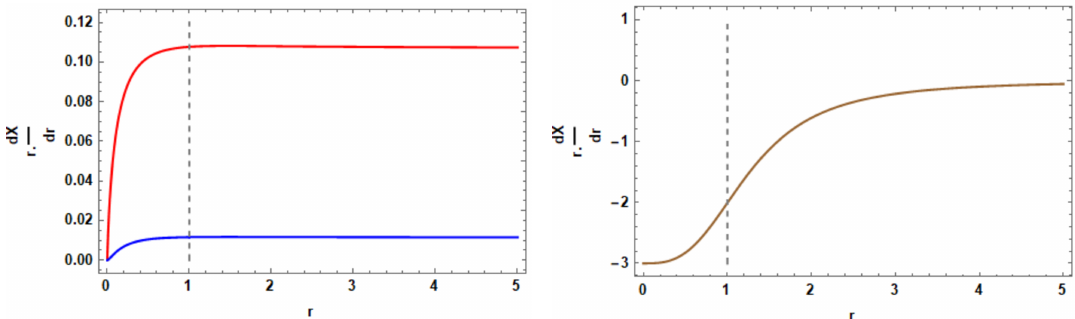
Figure 1. A flow from UV AdS to Kasner universe. This corresponds to a deformation parameter A 1 = 6 . 47 . For the left figure from top to bottom X are respectively φ ( r ) and χ ( r ) . For the right T figure X = log g 0 ( r ) . In the both figures dotted vertical line represents the position of horizon, r H . tt